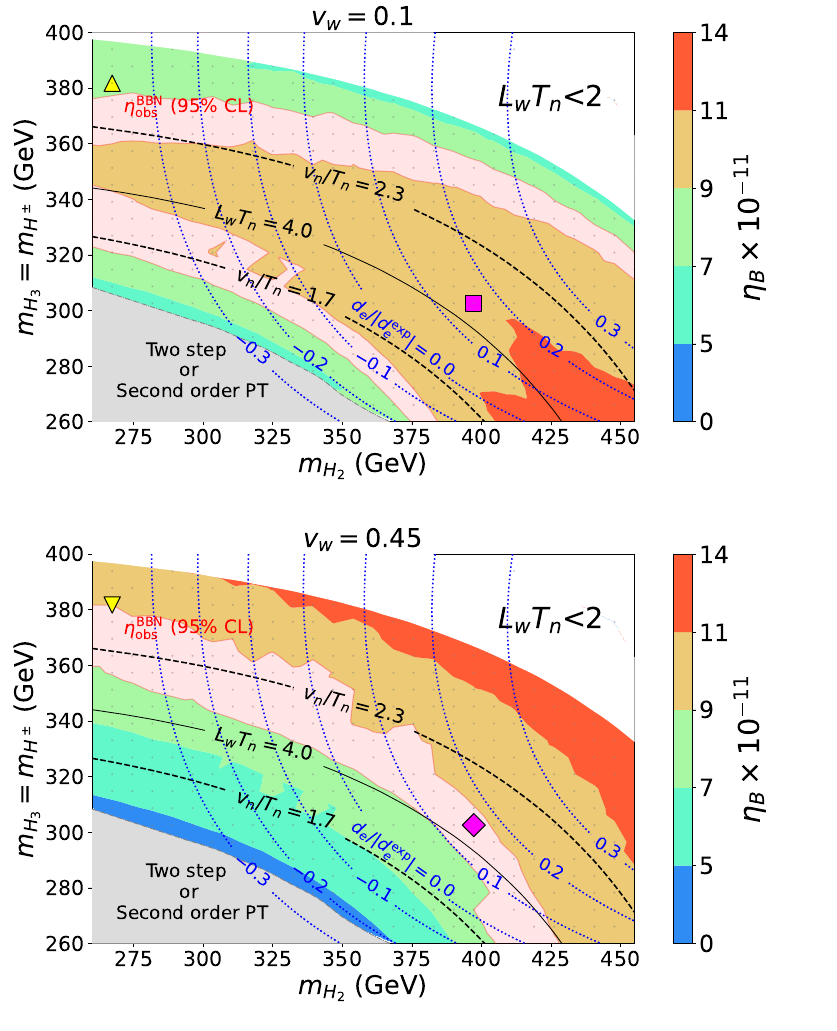
and m = m in the case of v = 0 . 1 (top) H 3 w H ± 2